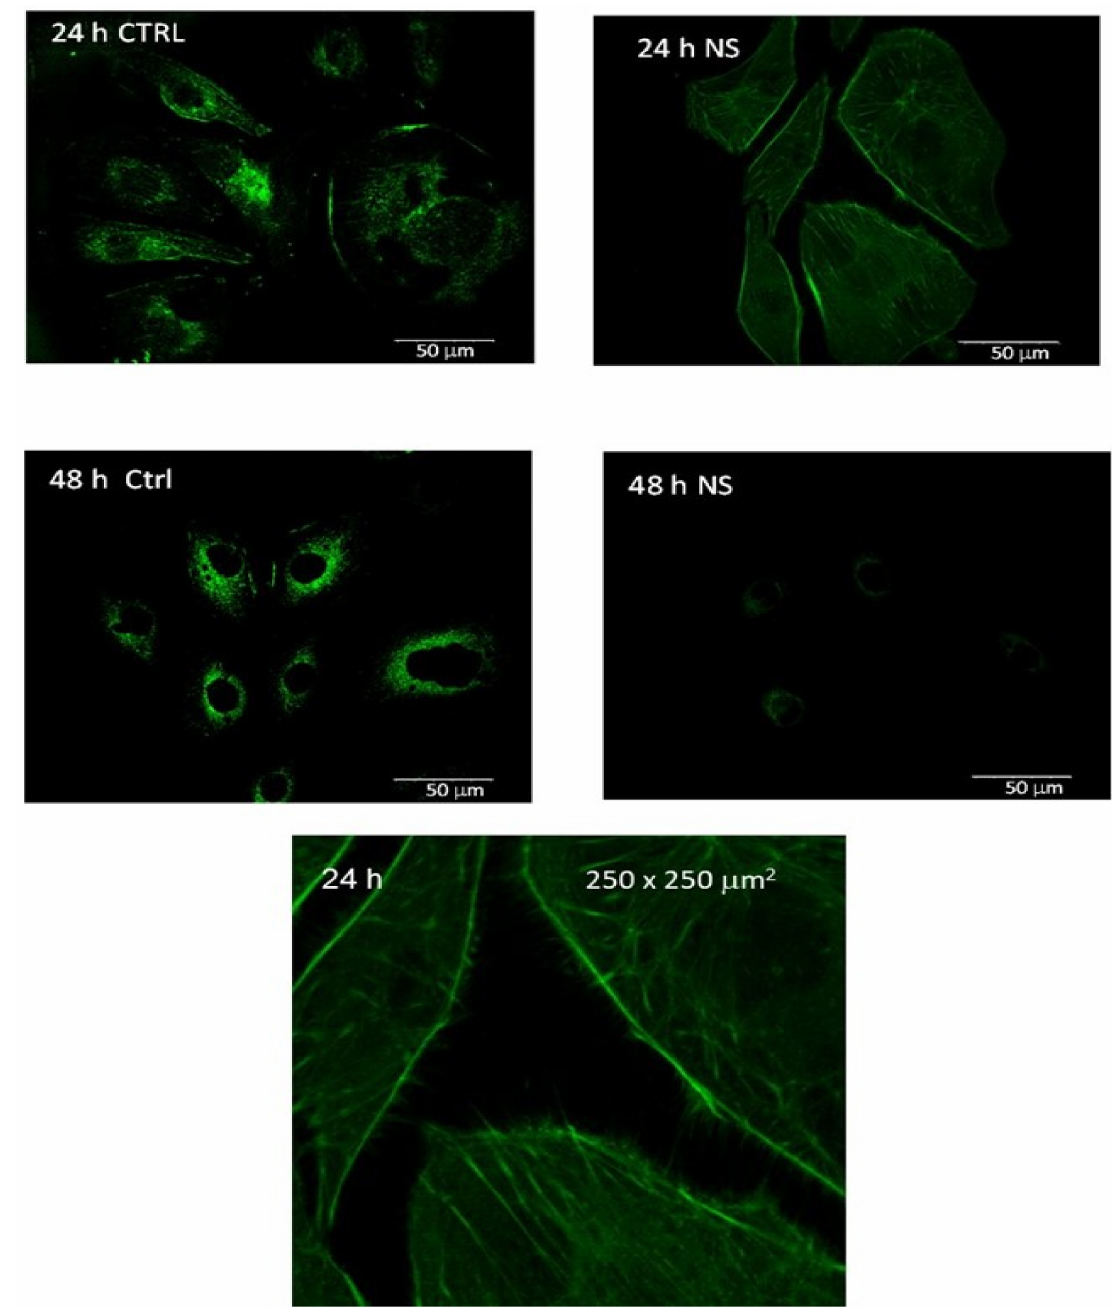
Figure 2. Vinculin expression in the melanoma control (CTRL) and 24 and 48 h after CaS dispersion treatment. The objective magnification is 60x. The image at the bottom represents a 250 × 250 µ m 2 region (magnified by a factor of about 4) of the 24 h measurement of the treated